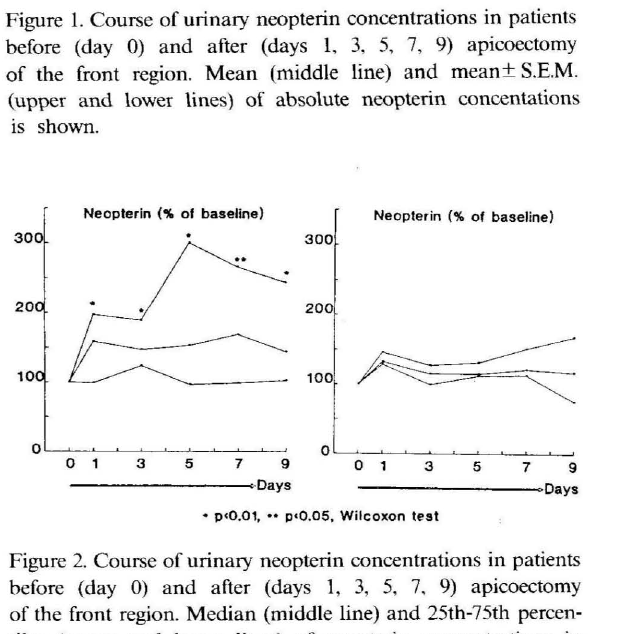
Figure 2. Course of urinary neopterin concentrations in patients before (day 0) and after (days 1, 3, 5, 7. 9) apicoectomy of the front region. Median (middle line) and 25th-75th percen tiles (upper and lower lines) of neopterin concentrations in percent of baseline levels is